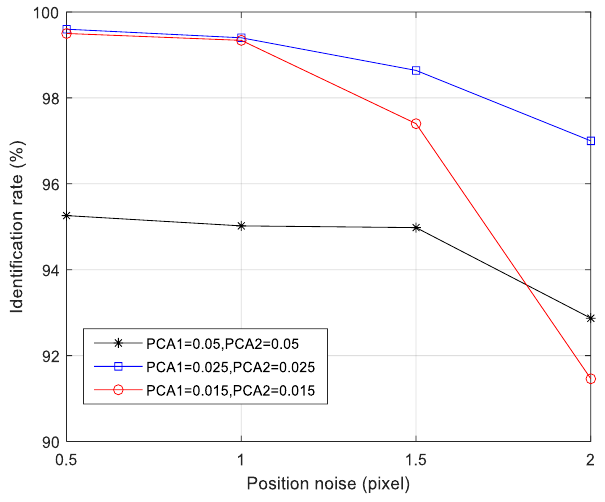
Figure 11. Identification rate versus positional noise with different discretized unit.